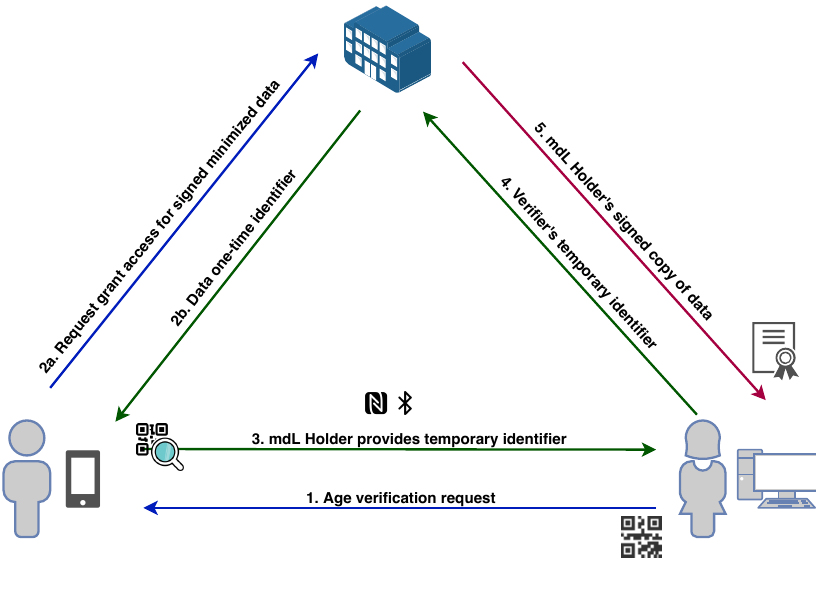
Figure 6. Mobile Driver’s License Use Case